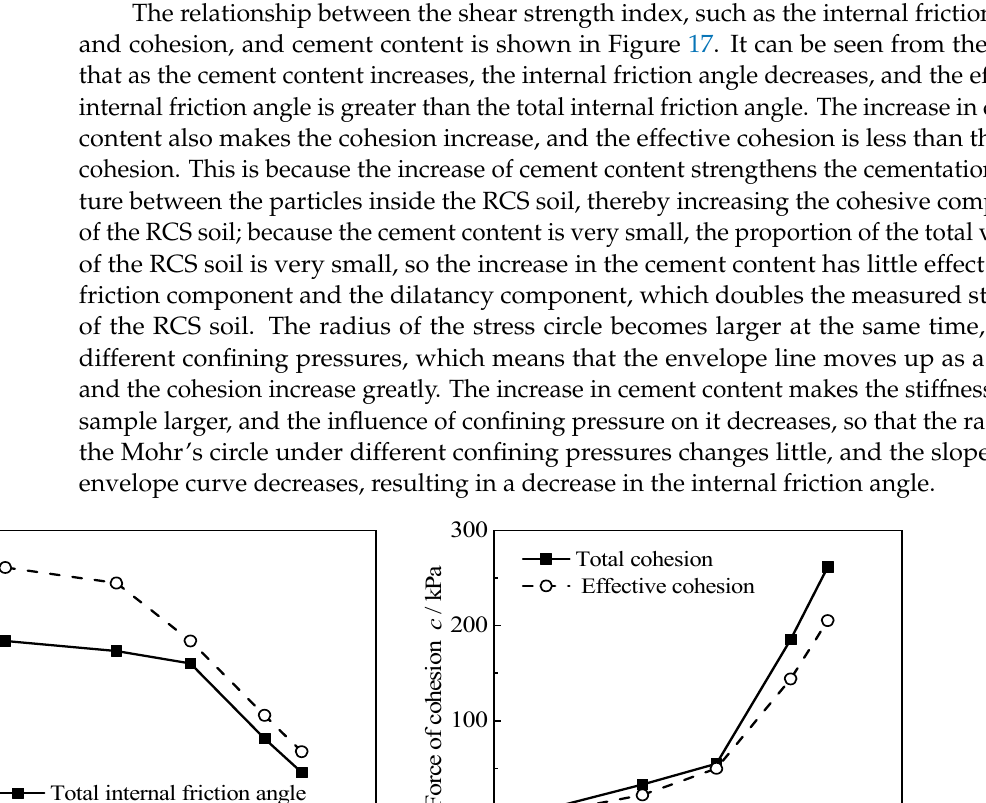
Figure 16. The shear strength mechanism of the soil [ 39].